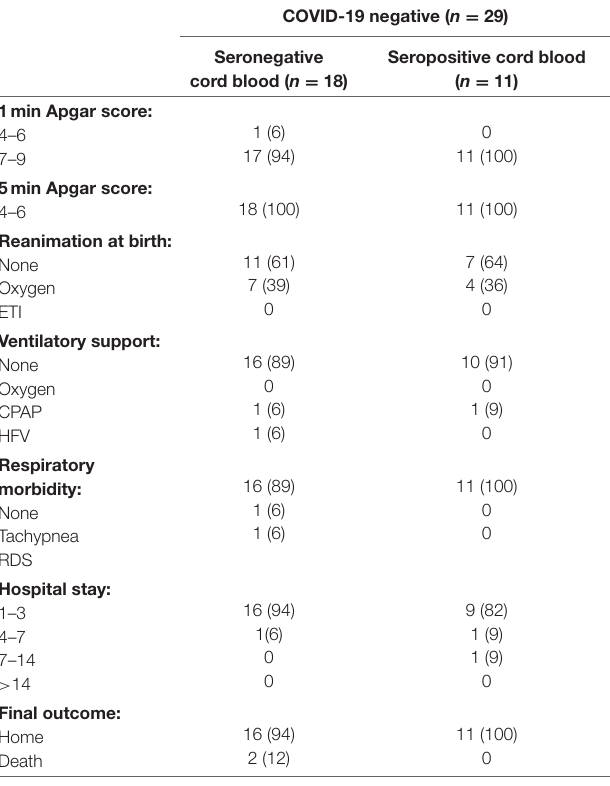
TABLE 2 | Neonatal outcomes relative to seropositivity in cord blood samples in the COVID-19 negative group. COVID-19 negative ( n = 29) Seronegative Seropositive cord blood cord blood ( n = 18) ( n =